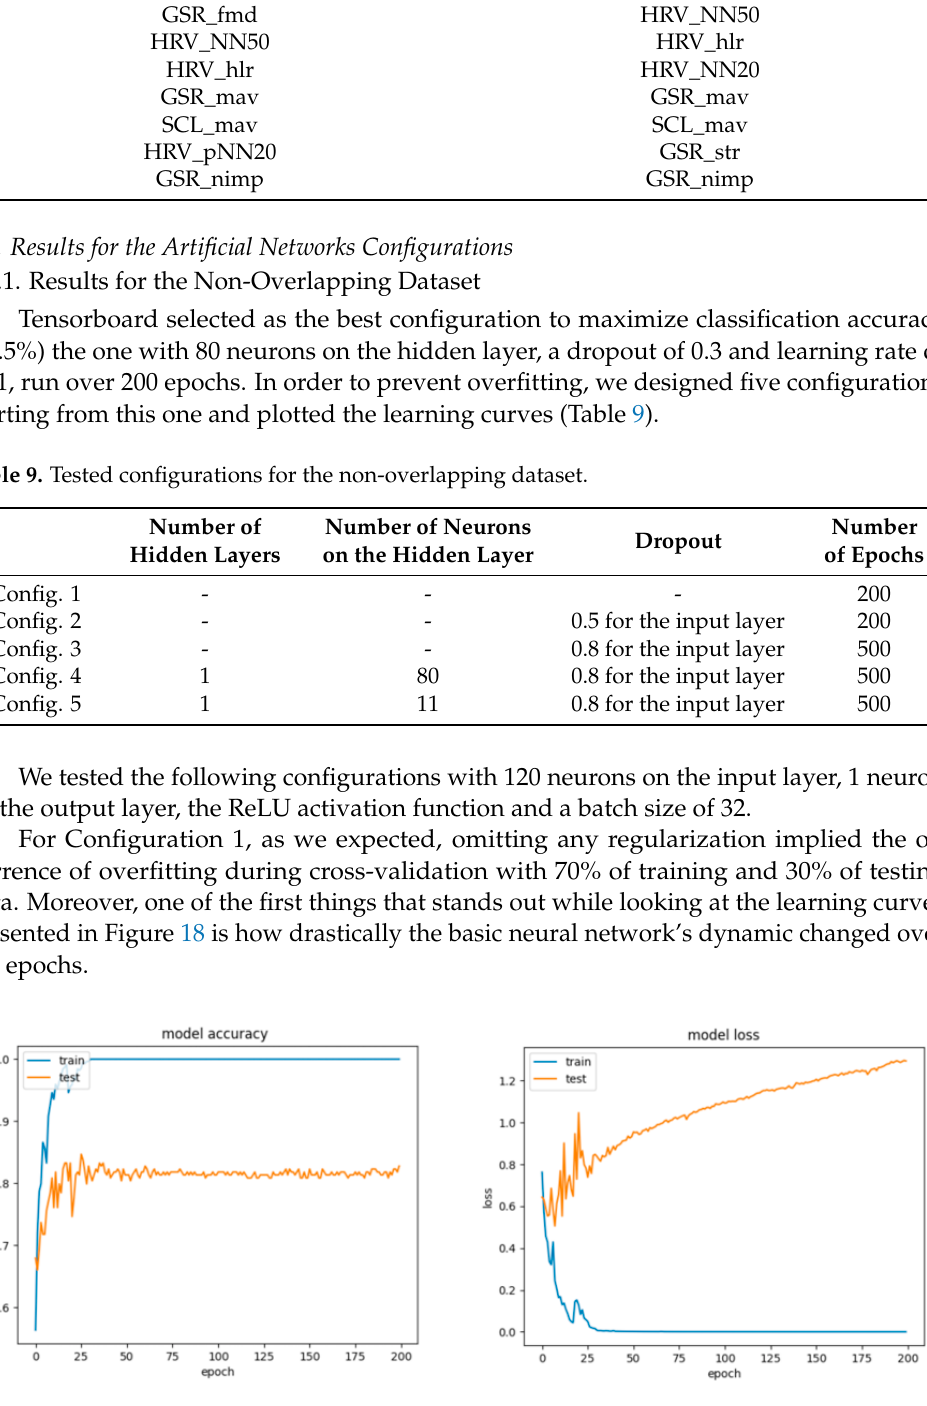
Figure 19. Accuracy and loss for Configuration 2, non-overlapping dataset.